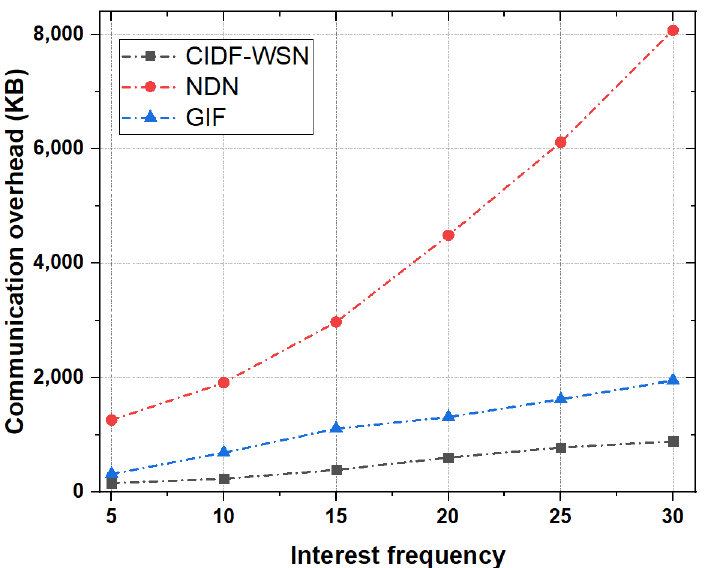
Figure 12. Communication overhead as a function of